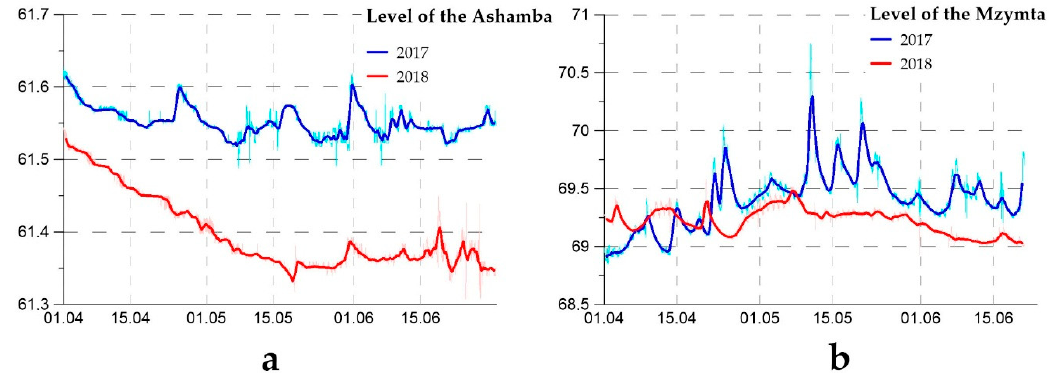
Figure 13. Changes in water level during April–June 2017–2018 in the rivers Ashamba ( a ) and Mzymta ( b ). Thin lines represent measurements every 10 min, whereas thick lines represent averages with one-day intervals.